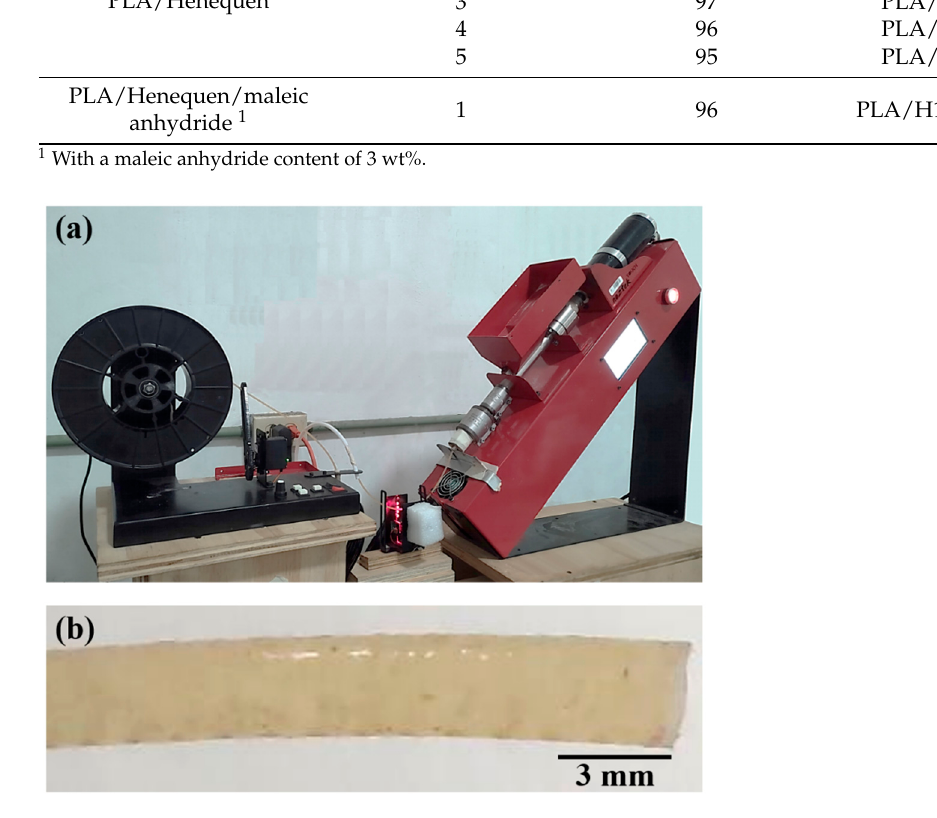
Figure 2. ( a ) Extrusion process of the NFRC filaments; ( b ) PLA/henequen filament with a fiber flour content of 3 wt%.